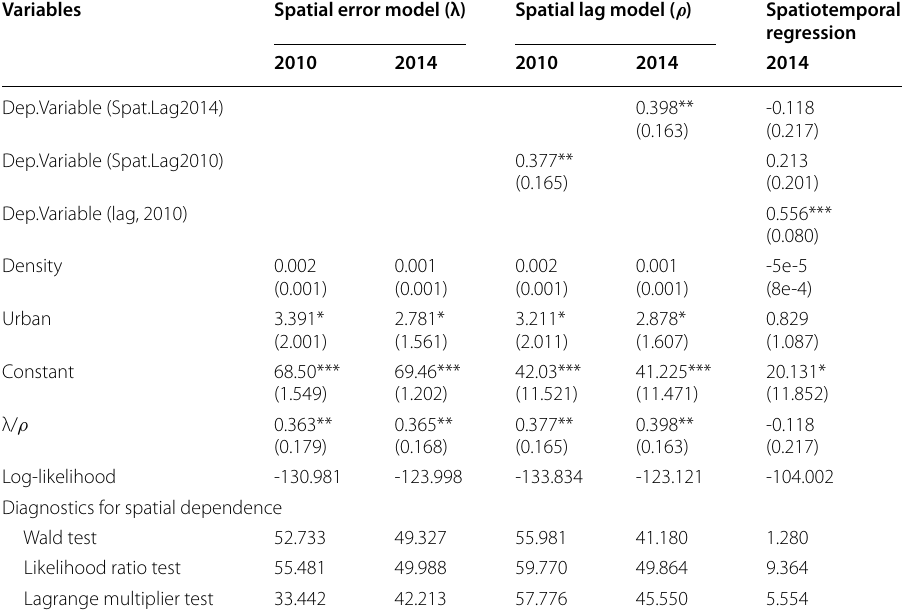
Table 4 Spatial error model, spatial lag model and spatiotemporal